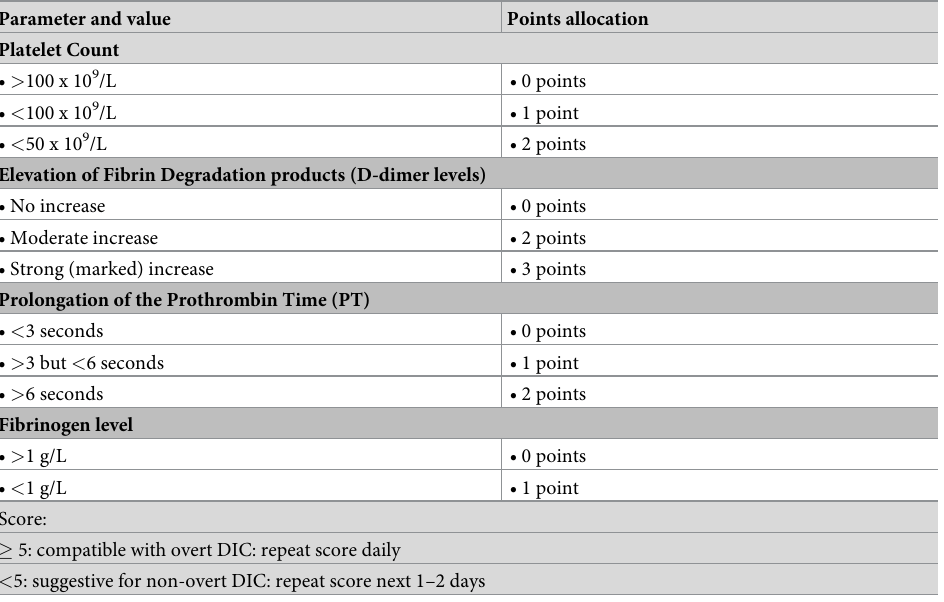
Table 1. The ISTH scoring system for overt